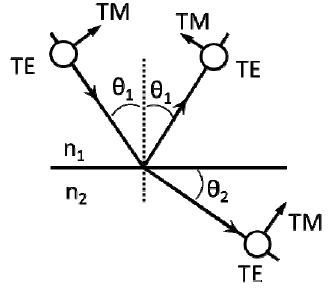
Figure 3. Diagram of transverse electric (TE) and transverse magnetic (TM) incident light at a non-zero angle of incidence on an interface plane for angle of incidence (AOI) < Brewster’s